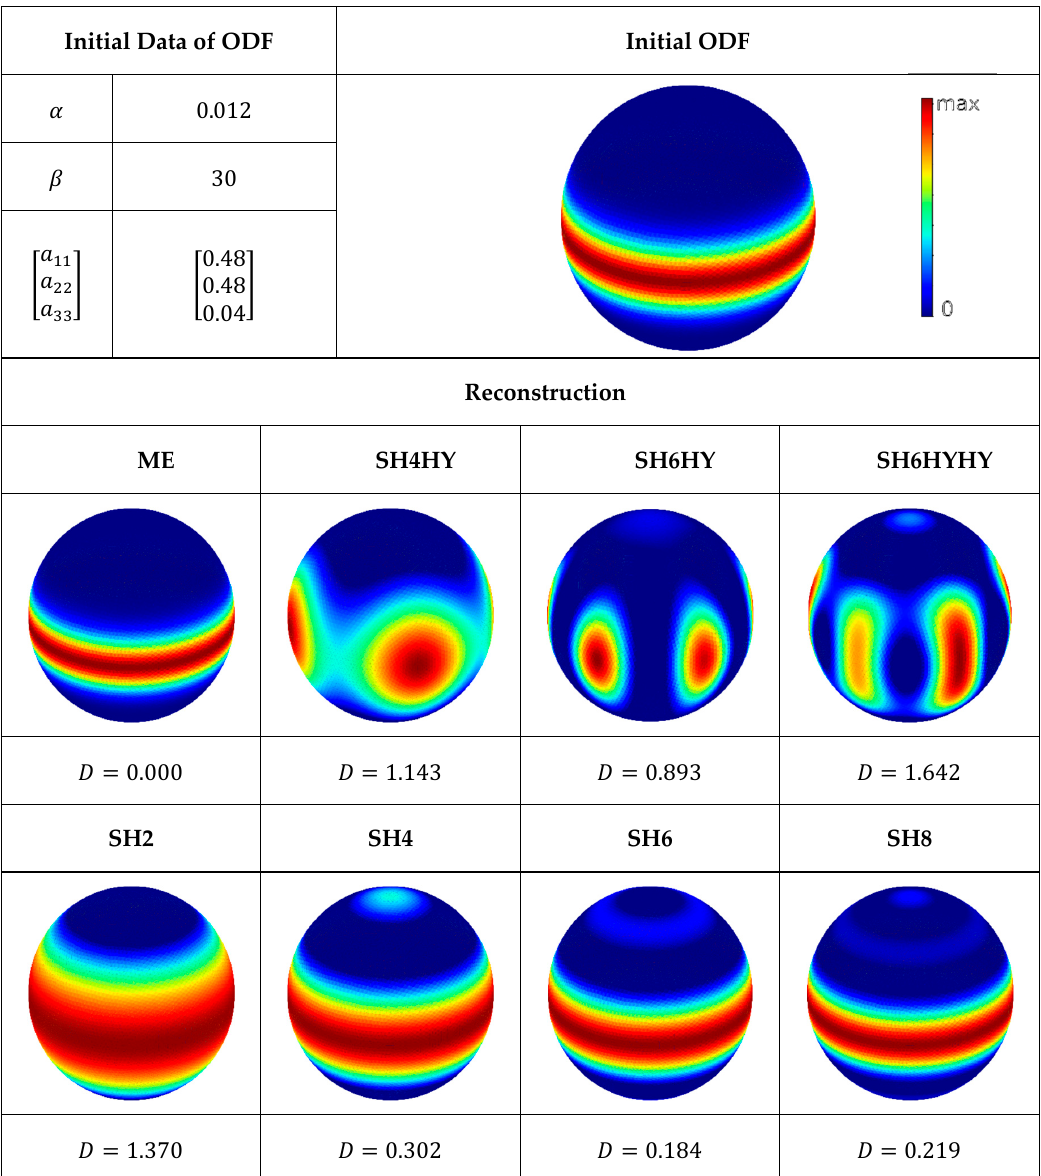
Figure 8. Initial ODF and data of fifth test case. Bottom: Reconstruction of test case with the different reconstruction methods.